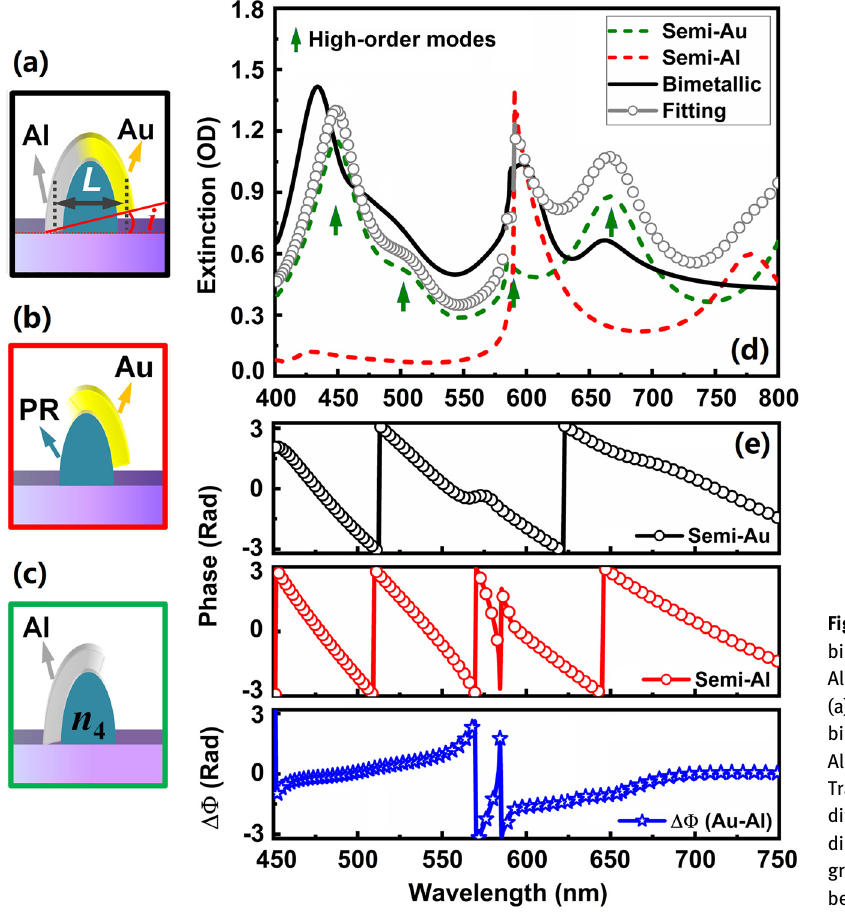
bimetallic grating. The fi tting curve with a relatively rough method of E fitting = W i E Au + W j E Al shows good agreement with the simulated spectrum of bimetallic metagrating, as plotted by grey circles, where E fi denotes the fi tting tting result of bimetallic metagrating, E and E denote the Au Al extinction spectra of semi-Au and semi-Al grating, respectively, W i and W j are the weight to balance the relationship between semi-Au and semi-Al grating. Those